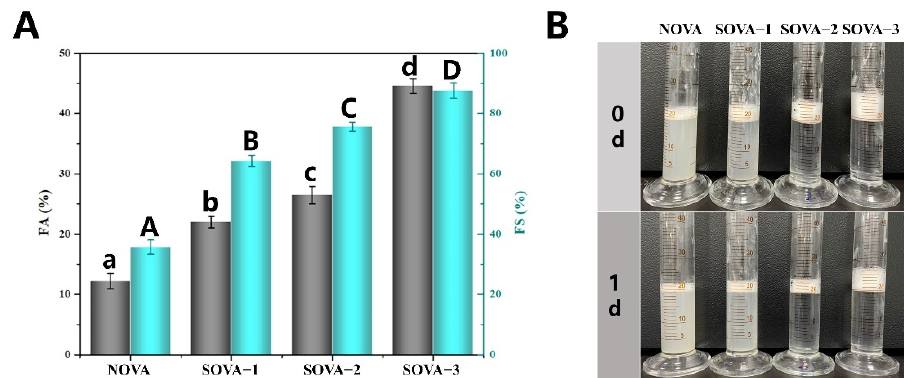
Figure 6. Foaming properties ( A ) and foam visual appearance stored for 0 d and 1 d ( B ) stabilized by OVA with different succinylated degrees. Different letters above the bars indicate a significant difference in the same indicator ( p < 0.05).